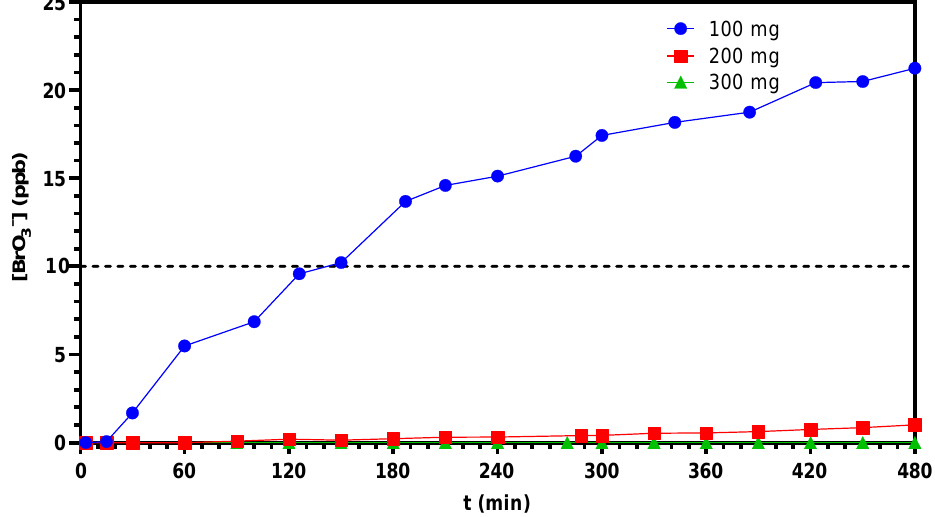
Figure 6. Bromate concentration (ppb) during continuous hydrogen reduction using different catalyst loadings of 1 wt.% Pd/MWCNT ‐ O mixed with 0.500 mm carborundum under H 2 . (Q = 5 mL min − 1 , H 2 = 50 cm 3 min − 1 , C (BrO 3 − ) = 200 ppb).